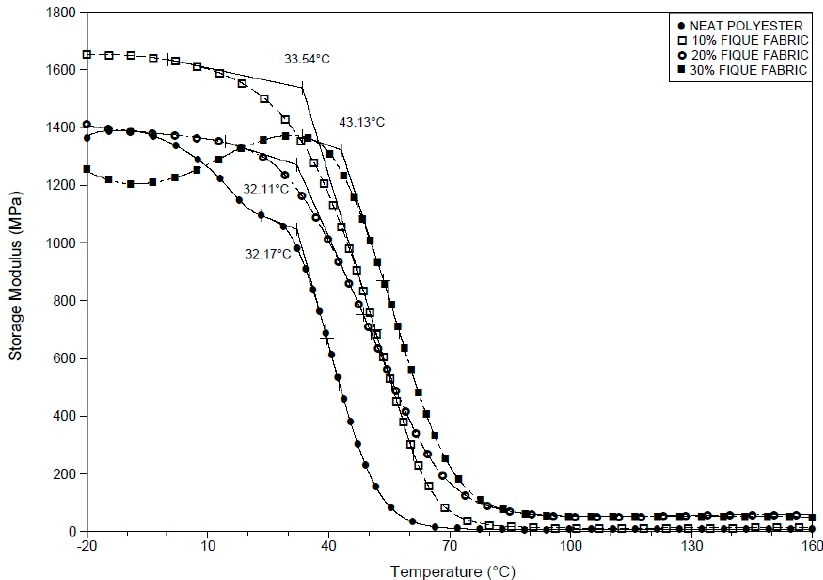
Figure 3. Storage modulus (E ′ ) curves for the neat polyester resin and for the composites reinforced with fique fabric.